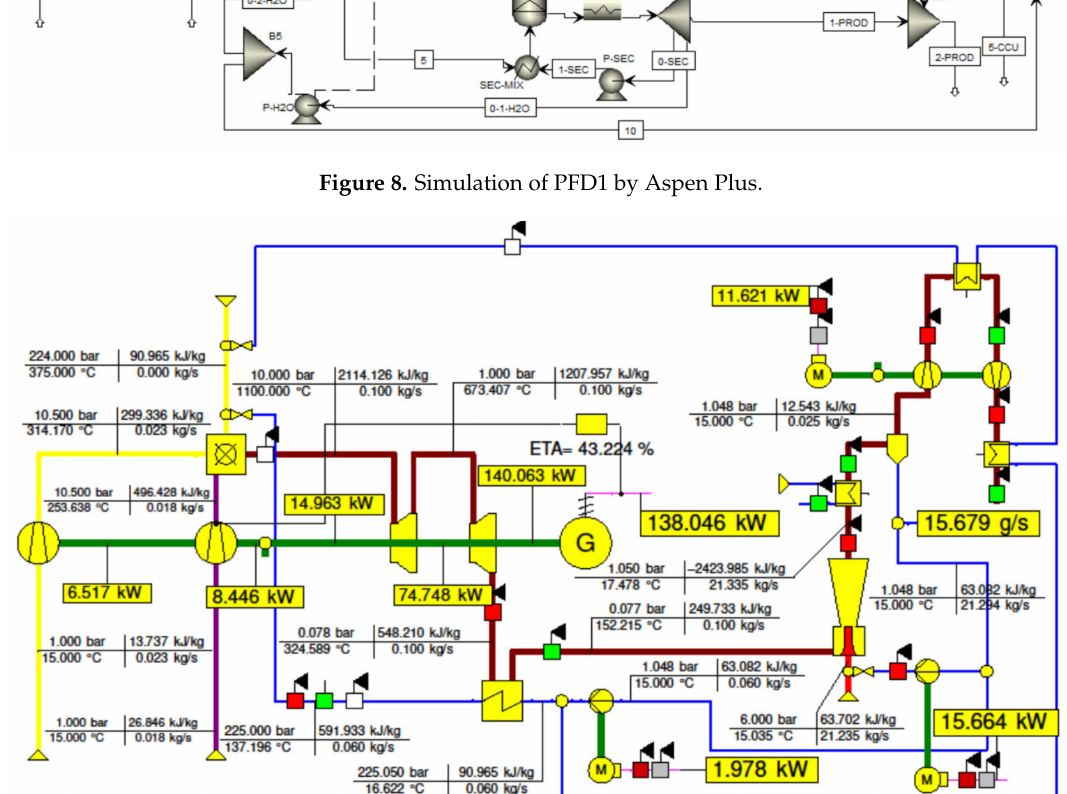
Figure 9. Simulation of PFD1 by by